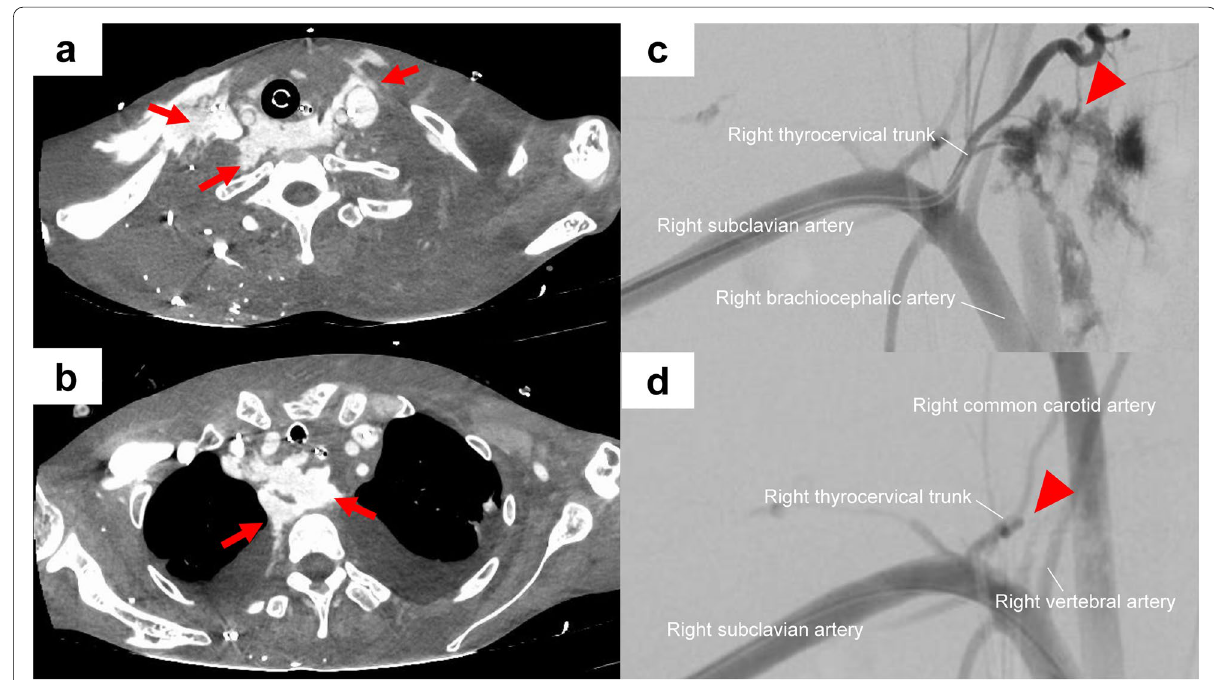
Fig. 1 Massive bleeding from a ruptured right thyrocervical trunk associated with right internal jugular vein puncture. Contrast-enhanced computed tomography shows massive contrast media extravasation around the neck ( a , arrows) and mediastinum ( b , arrows). Successive brachiocephalic artery angiography shows a characteristic “blush” appearance of a ruptured right thyrocervical trunk ( c , arrowhead). After selective arterial embolization using 33% N-butyl-2-cyanoacrylate, the extravasation has completely disappeared ( d ,